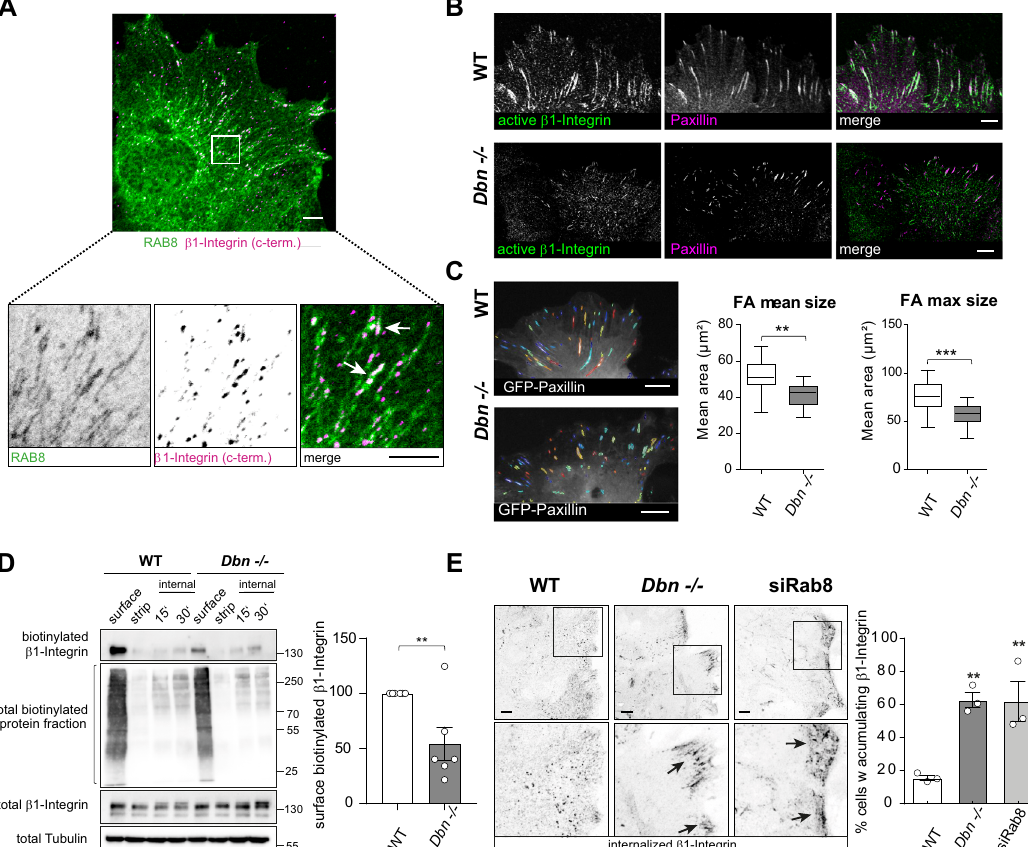
Fig. 5 DBN regulates RAB8 membrane traf fi cking of β 1-integrin during injury. A Detection of β 1-integrin (magenta in merged images) in RAB8 + tubules (green in merged images) in astrocytes. Arrows indicate RAB8 + tubules enriched with β 1-integrin. Representative image of three independent experiments. Scale bar: 10 µ m. Confocal images are single optical sections. B Confocal images of WT (upper panel) and Dbn − / − a s trocytes (bottom panel) after mechanical injury, labeled for active β 1-integrin (green) and paxillin (magenta). Representative images of three different experiments. Scale bars: 10 µ m. Images are single optical sections. C Focal adhesions (FA) in WT (upper panel) and Dbn − / − astrocytes (lower panel) expressing GFP-paxillin analyzed by the Focal Adhesion Analysis Server. Graph shows box and whisker plots (box extends from 25th to 75th percentiles, central line = median, whiskers comprise all values from minimum to maximum) of focal adhesion (FA) mean sizes and FA maximum sizes over 22 h during live imaging experiments ( n = 17 cells from three independent experiments, Student ’ s unpaired t test (two-sided): FA mean size ** P = 0.0013, t = 3.515 df = 32; FA max size *** P = 0.0004, t = 3.995 df = 32). Scale bars:10 µ m. D Streptavidin-pulldown of proteins after surface biotinlyation of injured WT and Dbn − / − astrocytes. Western blot shows biotinylated β 1-integrin in different conditions: immediately after surface biotinylation (surface), after removal of the surface-biotin label with MESNA (strip), 15 min and 30 min after incubating labeled astrocytes at 37 °C followed by MESNA treatment to remove the fraction of surface-exposed labeled proteins. Bar diagram shows quanti fi cation of surface β 1-integrin after normalization to total integrin levels displaying mean, individual points and SEM; n = 6 experiments, Student ’ s unpaired t test (two-sided) ** P = 0.0054, t = 3.541, df = 10. E Labeling of internalized ligand-bound β 1-integrin following antibody feeding in WT astrocytes (left image), Dbn − / − astrocytes (center image), and WT astrocytes after siRNA depletion of RAB8A and RAB8b (right image). Arrows indicate accumulations of β 1-integrin directly beneath the leading edge of Dbn − / − or RAB8-depleted astrocytes. Boxes in upper panels are magni fi ed in lower panels. Images are confocal stacks. Bar diagram shows quanti fi cation of astrocytes with antibody- labeled β 1-integrin at leading edges displaying mean, individual points and SEM;. n = 20 – 37 cells from three experiments; one-way ANOVA F = 12.57, DFn = 2, DFd = 6 with Dunnett ’ s multiple comparisons test WT vs Dbn − / − : ** P = 0.0083, WT vs siRab8: ** P = 0.0091. Source data are provided as a Source Data fi (Figure S7B). In summary, astrocytes from Dbn − / − mice show they were fi lled with amorphous, electron-dense material that was surrounded by double or multiple concentric membrane layers excessive, injury-speci fi c accumulation of membrane-derived (Fig. 6A) 44 . Quanti fi cation of multilamellar bodies at injury and material in both astrocytic processes and endfeet. contralateral sites of WT and Dbn − / − brains showed that this compartment was induced upon injury only in the absence of DBN (Fig. 6A, B). In addition, we investigated the ultrastructure We have identi fi ed the function of DBN in protecting the brain of astrocytic endfeet, which sustain high levels of membrane from tissue damage following injury. We show that (1) under traf fi cking during nutrient and metabolite uptake, and ef fl ux of physiological conditions, DBN protein is not expressed in astro- waste products 2 . Analogous to astrocyte processes, astrocyte cytes; however, its injury-induced upregulation in reactive astro- endfeet at the injury site in WT brains contained several endo- cytes is required for the coordinated formation and maintenance somal structures. In contrast, excessive amounts of multilamellar of astrocyte scars, demonstrating its essential role in effective tis- bodies fi lled the endfeet at injury sites in Dbn − / − mice sue protection in the brain. (2) At the cellular level, DBN shifts the